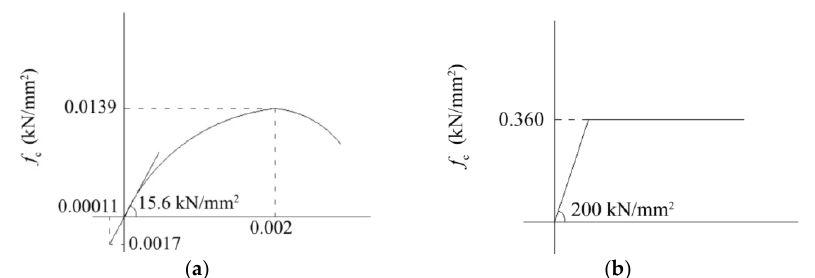
Figure 12. Material models. ( a ) Concrete; ( b ) Reinforcement.